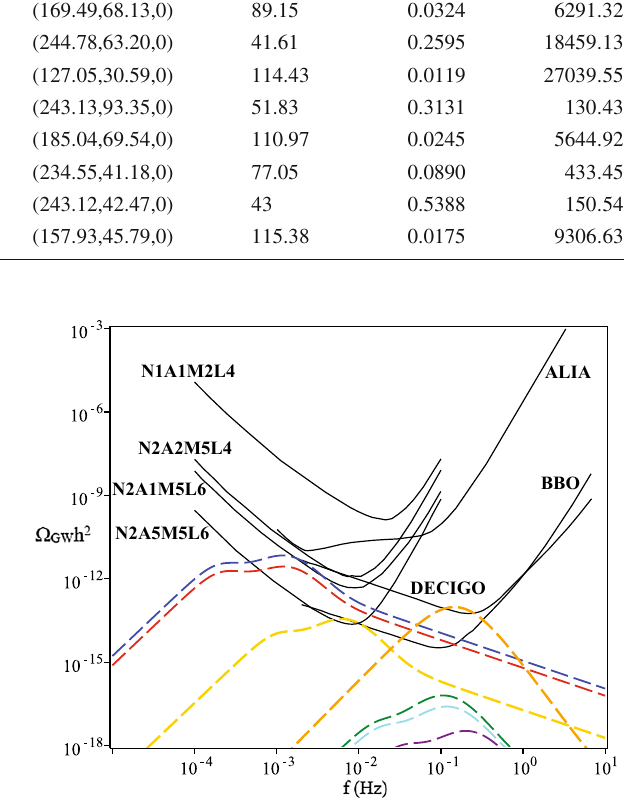
Fig. 1 The dashed blue, red, yellow, orange, green, cyan and purple lines represent the GW signal for BM7, BM4, BM6, BM2, BM1, BM5 and BM8, respectively. The solid black lines represent the sensitivity curves and are labeled by the name of the detectors. For eLISA, the sensitivity curves are labeled by the name of the configuration